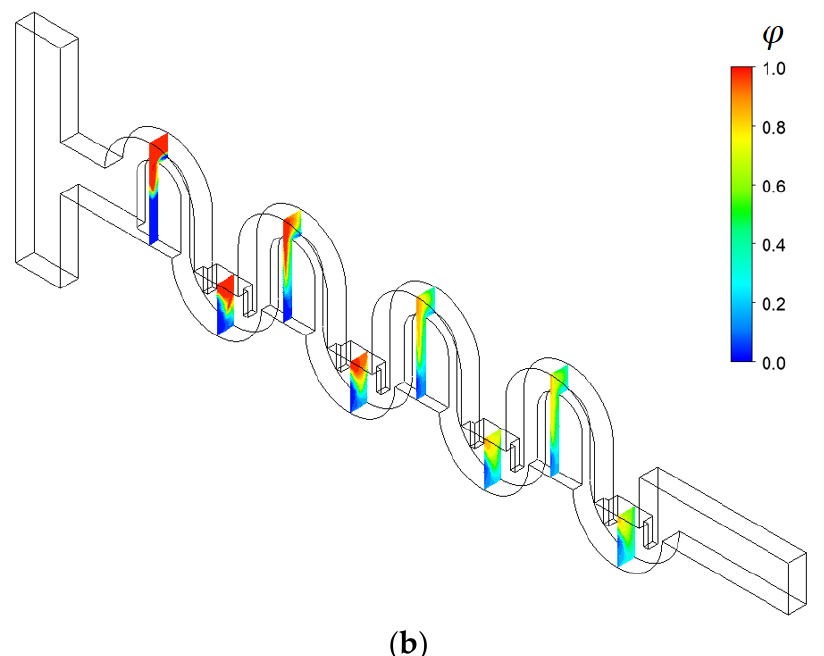
Figure 9. Comparison of mixing evolution along the micromixer for Re = 10: ( a ) No submergence, ( b ) Submerged, W s = 60 µ m.